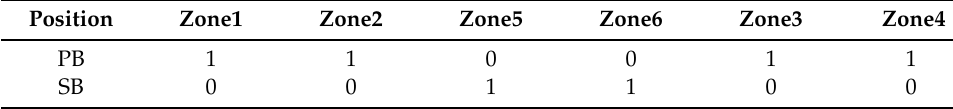
Figure 4. Schematic view of SPS under pre-fault state. Table 2. Switch configuration (pre-fault).